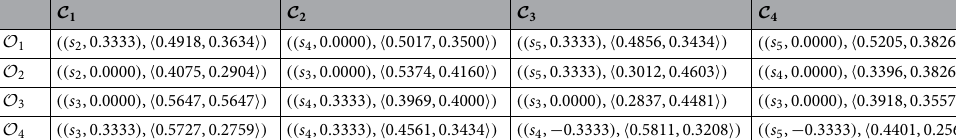
Table 8. Aggregated q-rung orthopair fuzzy 2-tuple linguistic decision matrix.